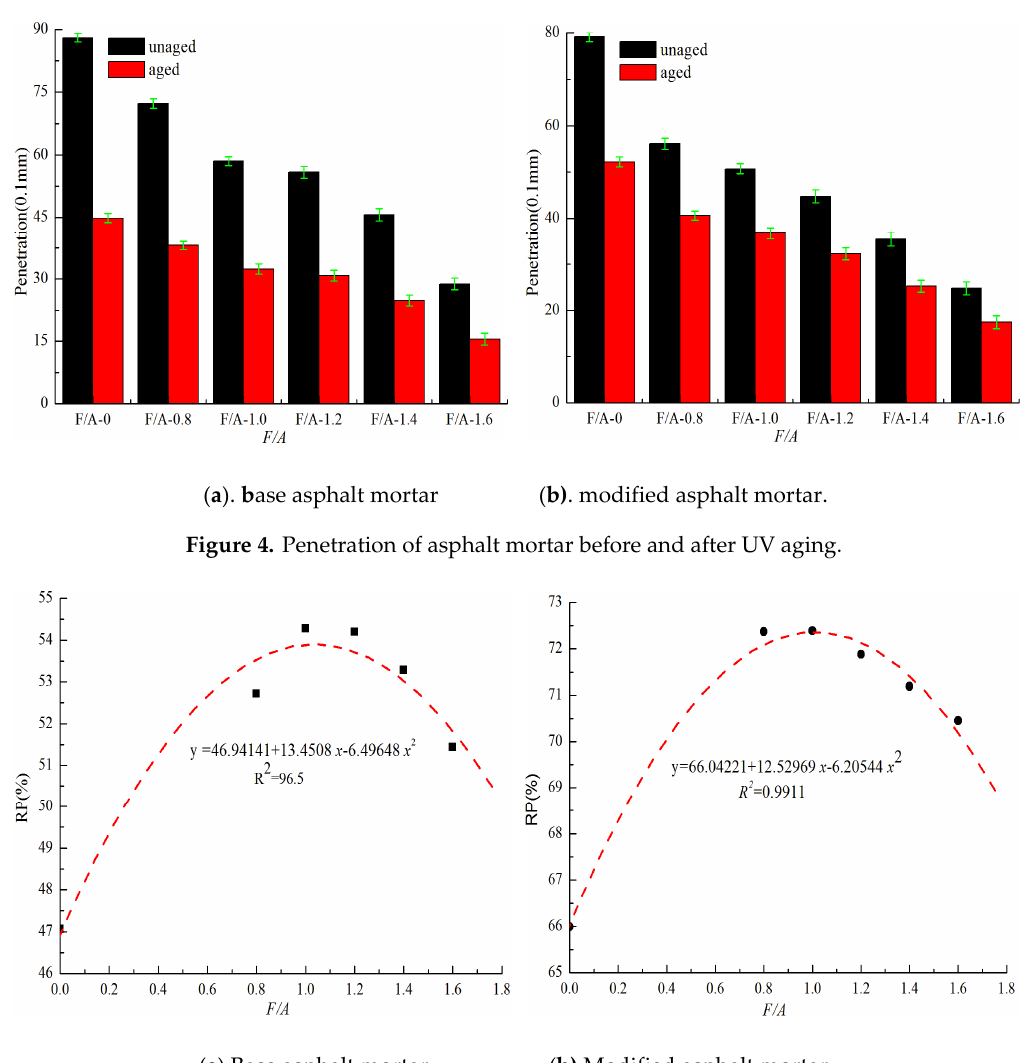
Figure 5. Residue penetration of asphalt mortar.